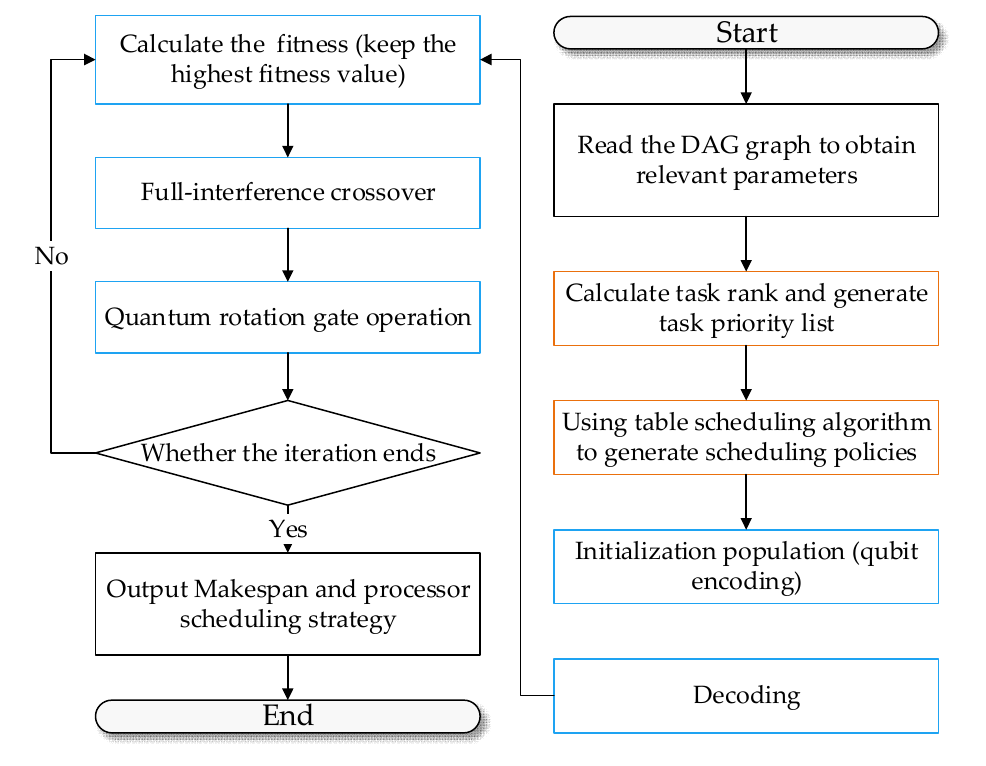
Figure 8. Flow chart of the HSP-QGA. The main operation flow of the HSP-QGA (Algorithm 1). Algorithm 1: Main operation process of the